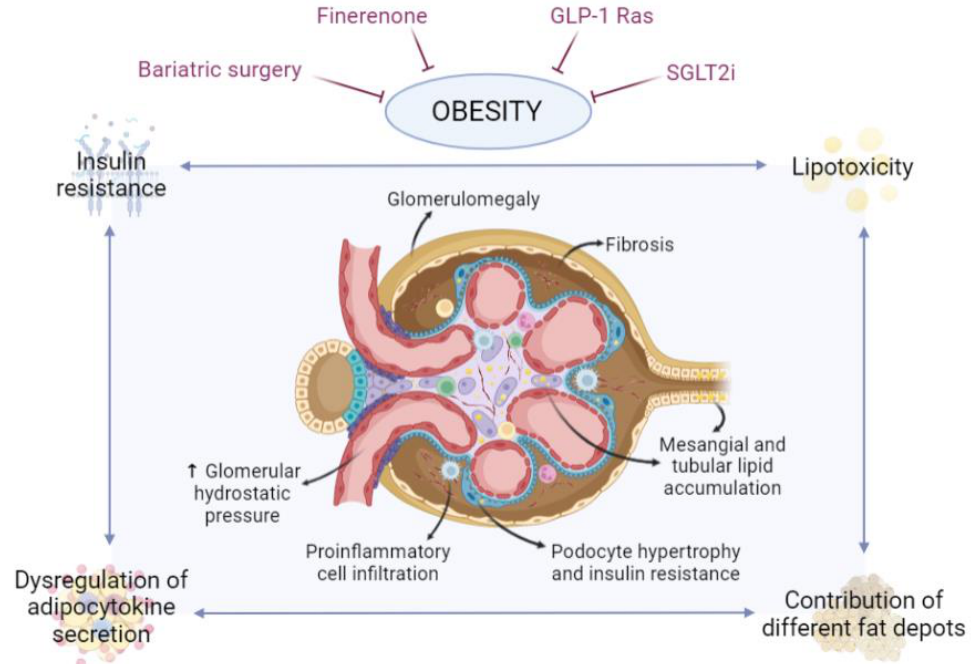
Figure 1. Involvement of adipose tissue in obesity-related glomerulopathy. During obesity, adipose tissue, and specifically certain depots adjacent to the kidney, undergoes changes that may affect the kidney, leading to lipotoxicity, alterations in the pattern of adipokine and cytokine secretion and associated insulin resistance. Effects on the kidney, and specifically on the nephron, may include fat accumulation in mesangial, tubular and podocyte cells, podocyte hypertrophy and insulin resistance, glomerulomegaly, proinflammatory cell infiltration, hemodynamic alterations and fibrosis. Ultimately, this can affect the functionality of the nephron, disrupting the glomerular filtration barrier and potentially leading to the development of chronic kidney disease. There are currently several strategies to combat obesity and, consequently, its deleterious effects, such as kidney damage, including finerenone, GLP-1 Ras, SGLT2i and bariatric surgery, among others. Created